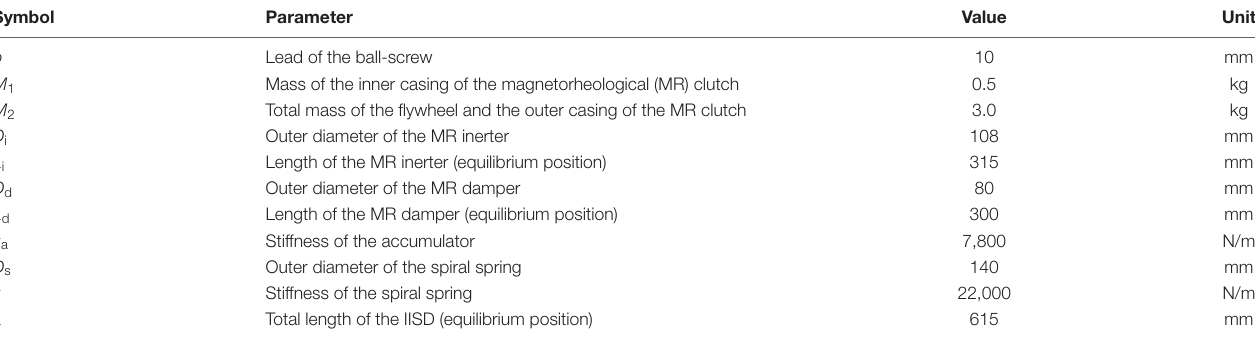
TABLE A1 | Structural parameters of the integrated inerter-spring-damper.